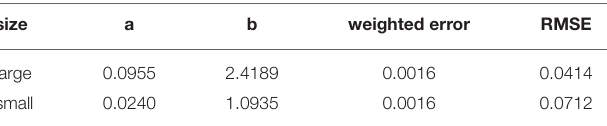
Fitting is done by minimizing the weighted errors between the measurements and model using the standard deviation between two technical replicates as weighting factor. The root mean square error (RMSE) is also